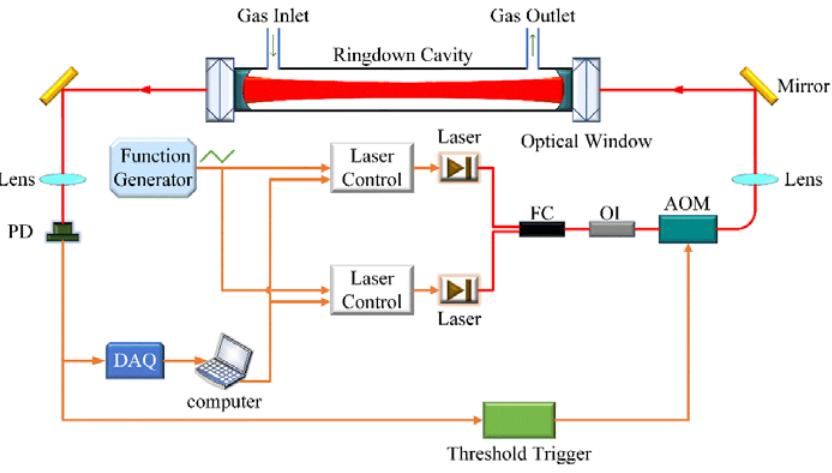
Figure 1. Schematic of the experimental setup with two lasers. FC, fiber-optic combiner; OI, optical isolator; AOM, acousto-optic modulator as an optical switch; PD, photodiode detector; DAQ, data acquisition.